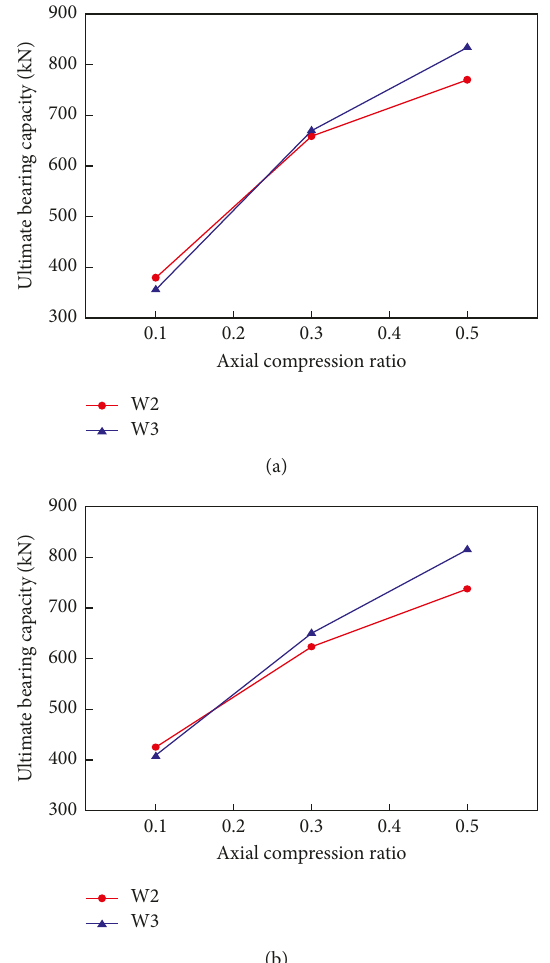
Figure 33: Variation of the ultimate bearing capacity under different axial compression ratios. (a) Simulated results. (b) Calculated